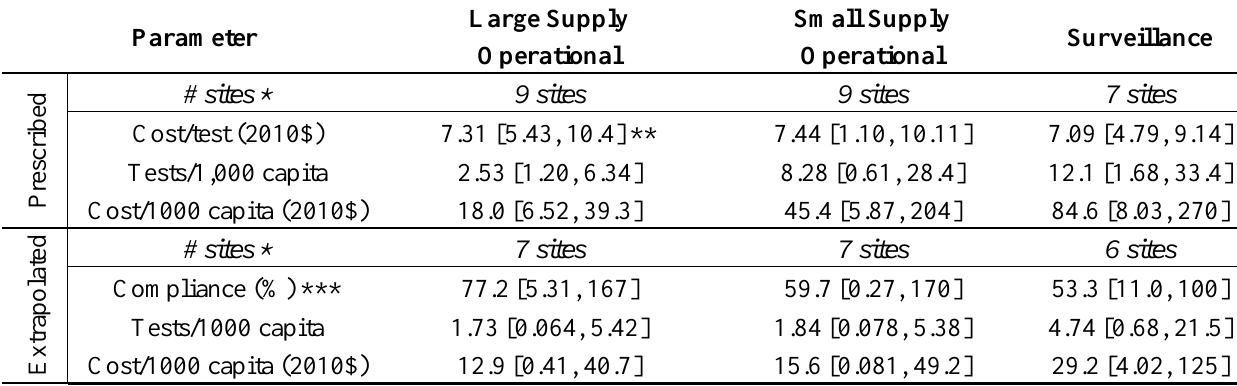
Table 6. Prescribed and extrapolated levels of testing and testing costs by scenario averaged across nine study